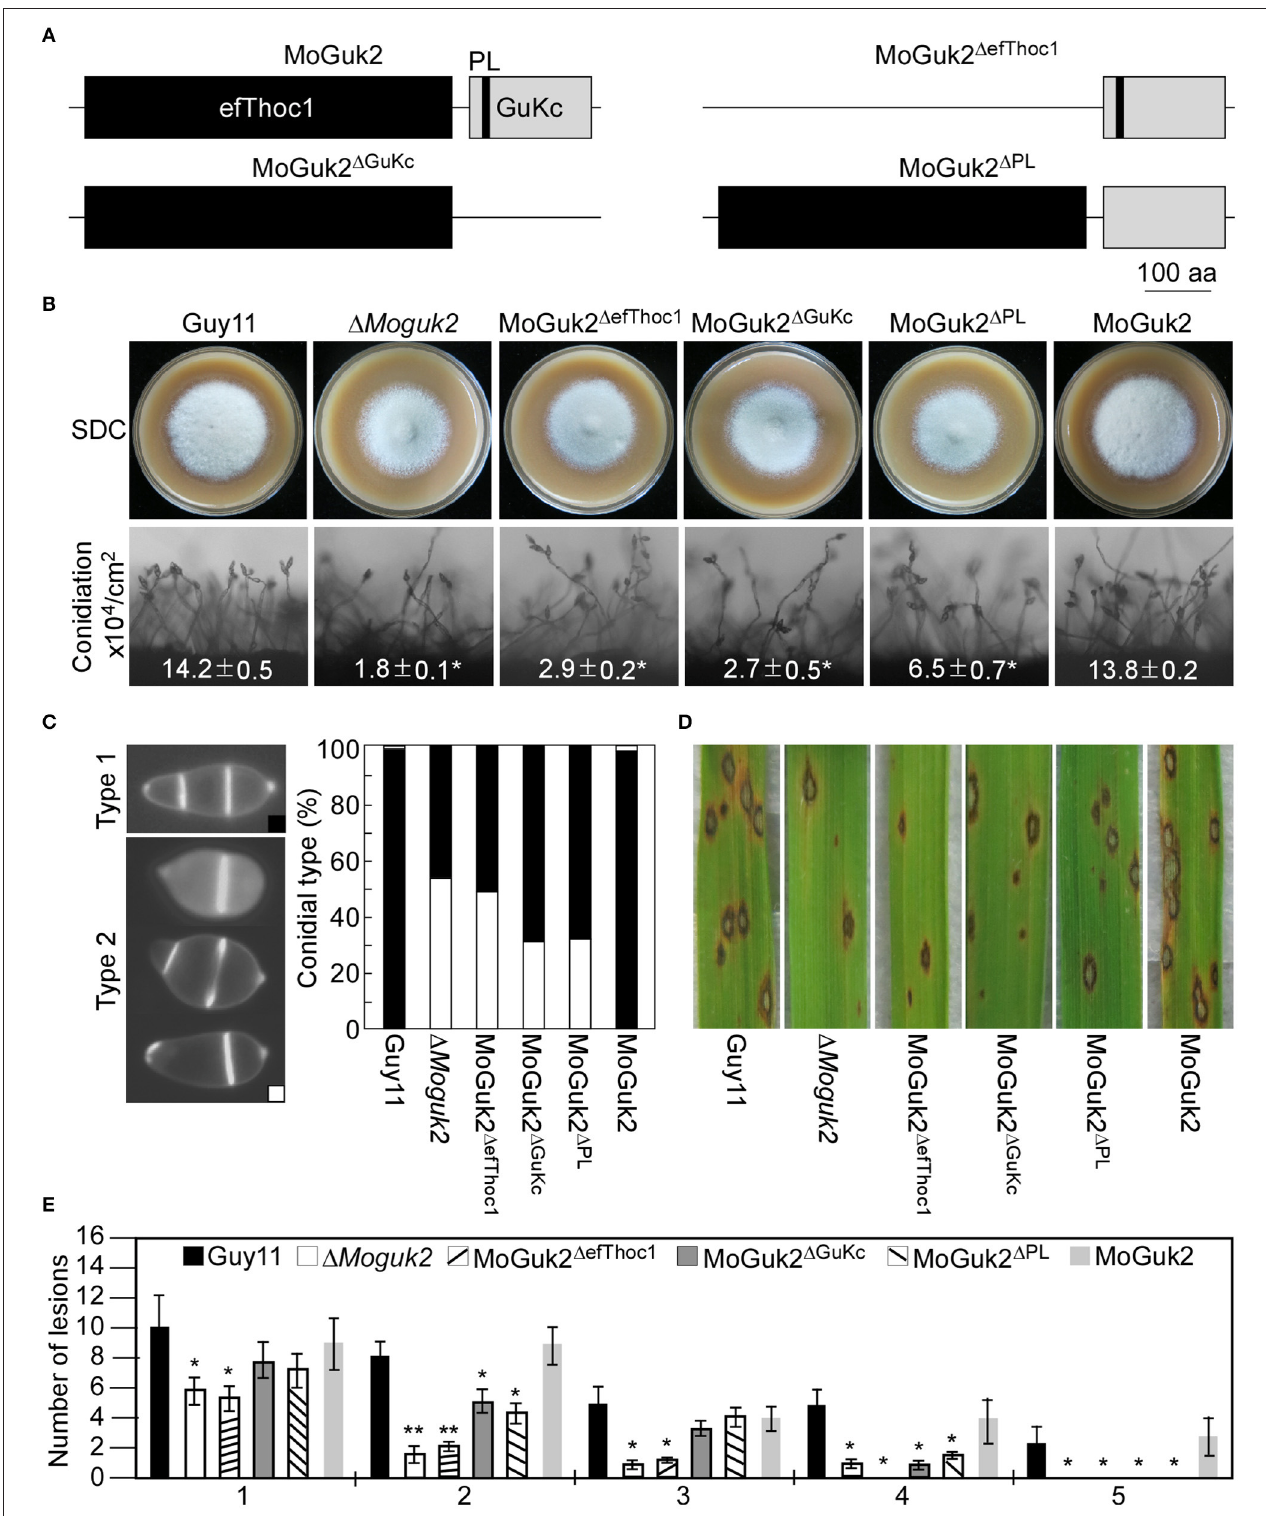
FIGURE 9 | The efThoc1, GuKc, and P-loop domains are required for the full function of MoGuk2. (A) Domain deletion strategy and diagram of MoGuk2. (B) Vegetative growth and conidiation of the indicated strains. (C) Statistical analyzes the abnormal conidia of the indicated strains. (D) Spraying assay. Conidial suspensions prepared from the indicated strains were sprayed onto 2-week-old rice seedlings, and photographed at 7 dpi. (E) Statistical analysis of the number of lesions in each type. Error bars are standard deviations and asterisks represent significant differences at P < 0.01.